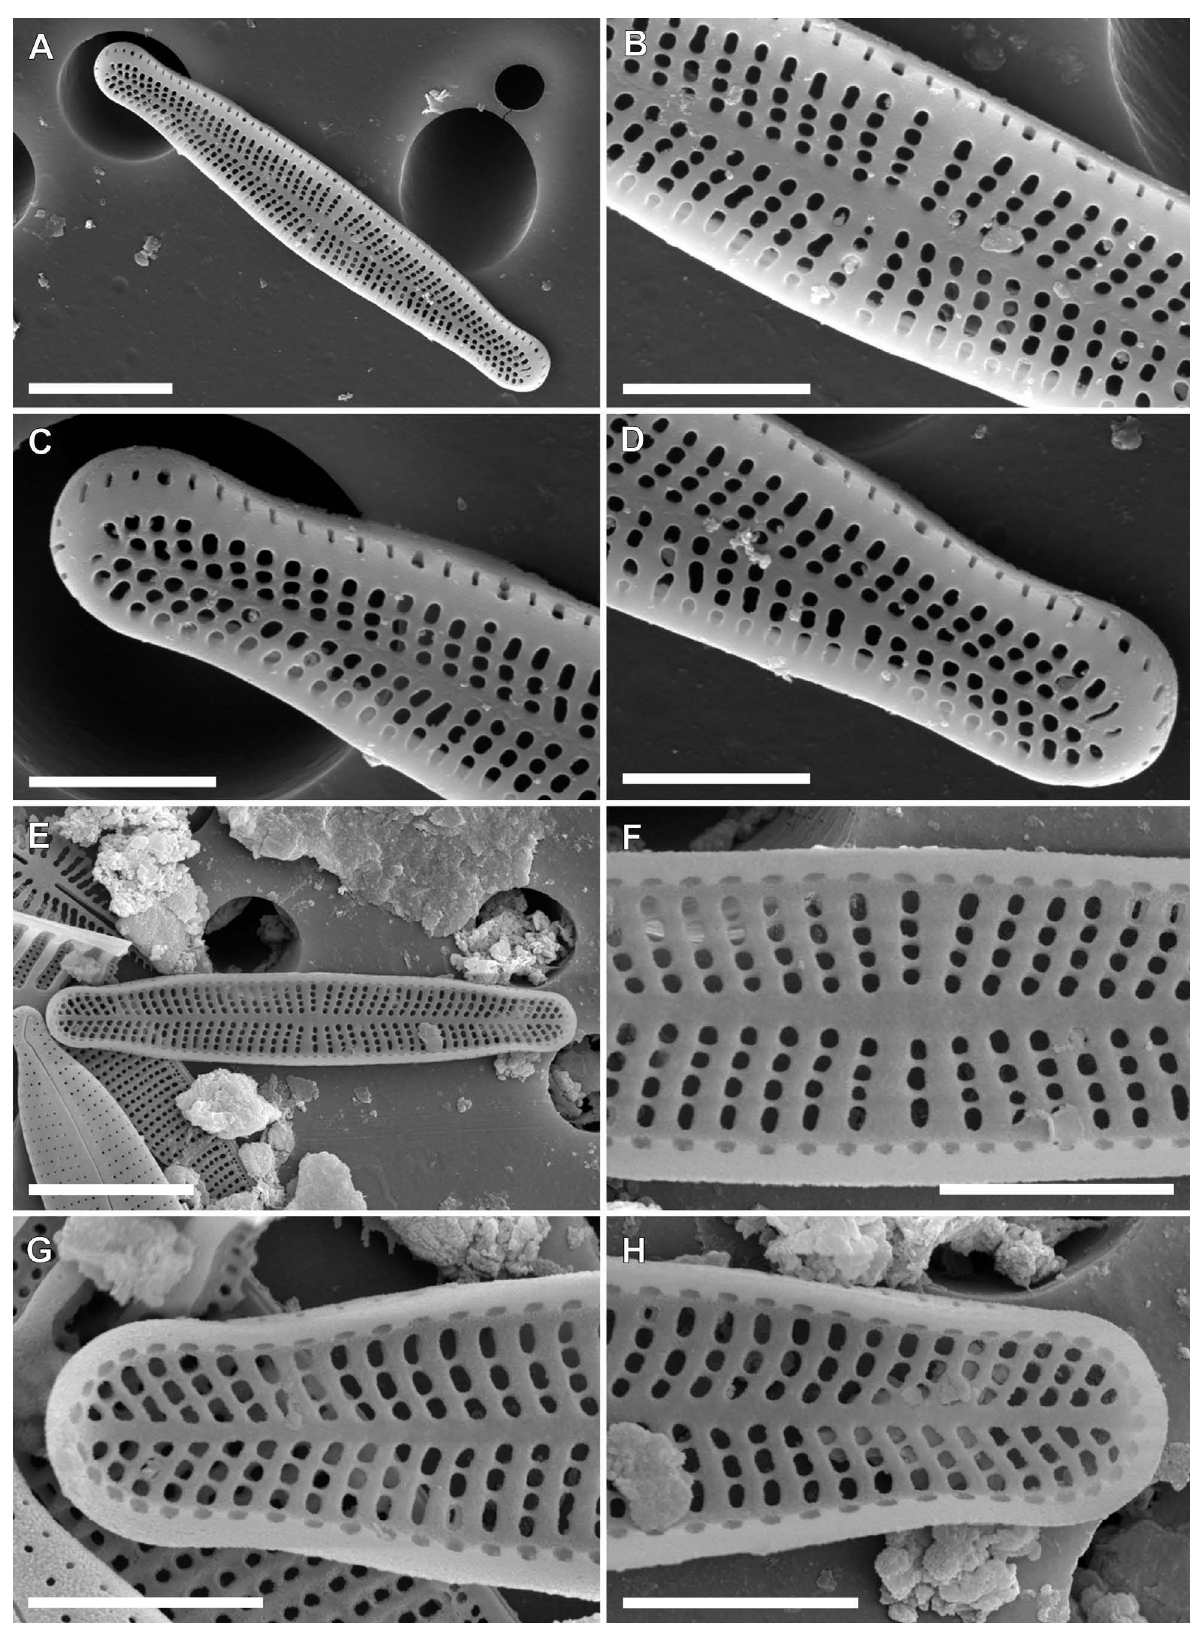
Figure 4. Achnanthidium barlasii sp. nov., SEM micrographs. A . General external valve view of a rapheless valve. B . Details of central area. C , D . Details of apices. E . General internal valve view of a rapheless valve. F . Details of central area. G , H . Details of apices. Scale bars 5 µm (A, E), 2 µm (F–H), 1 µm